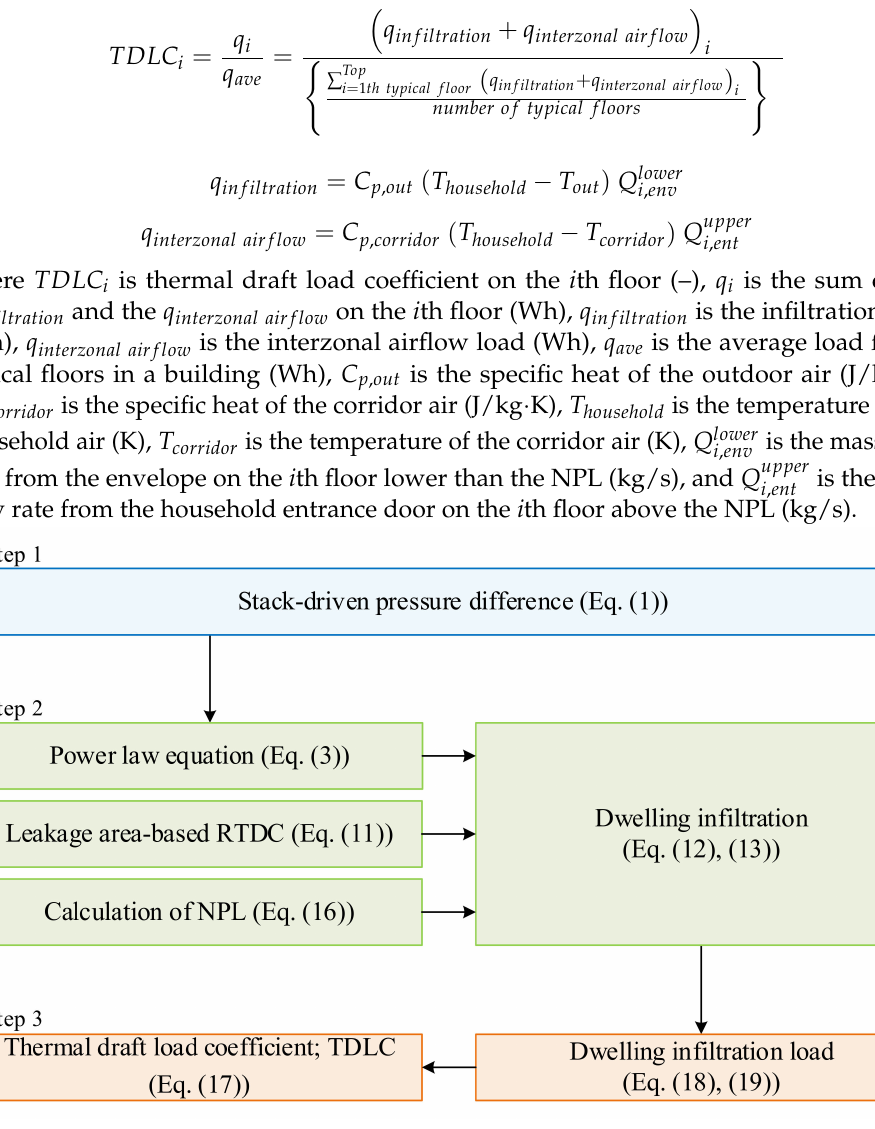
Figure 2. Development process of the theoretical models to calculate TDLC.3. Airflow and energy simulation